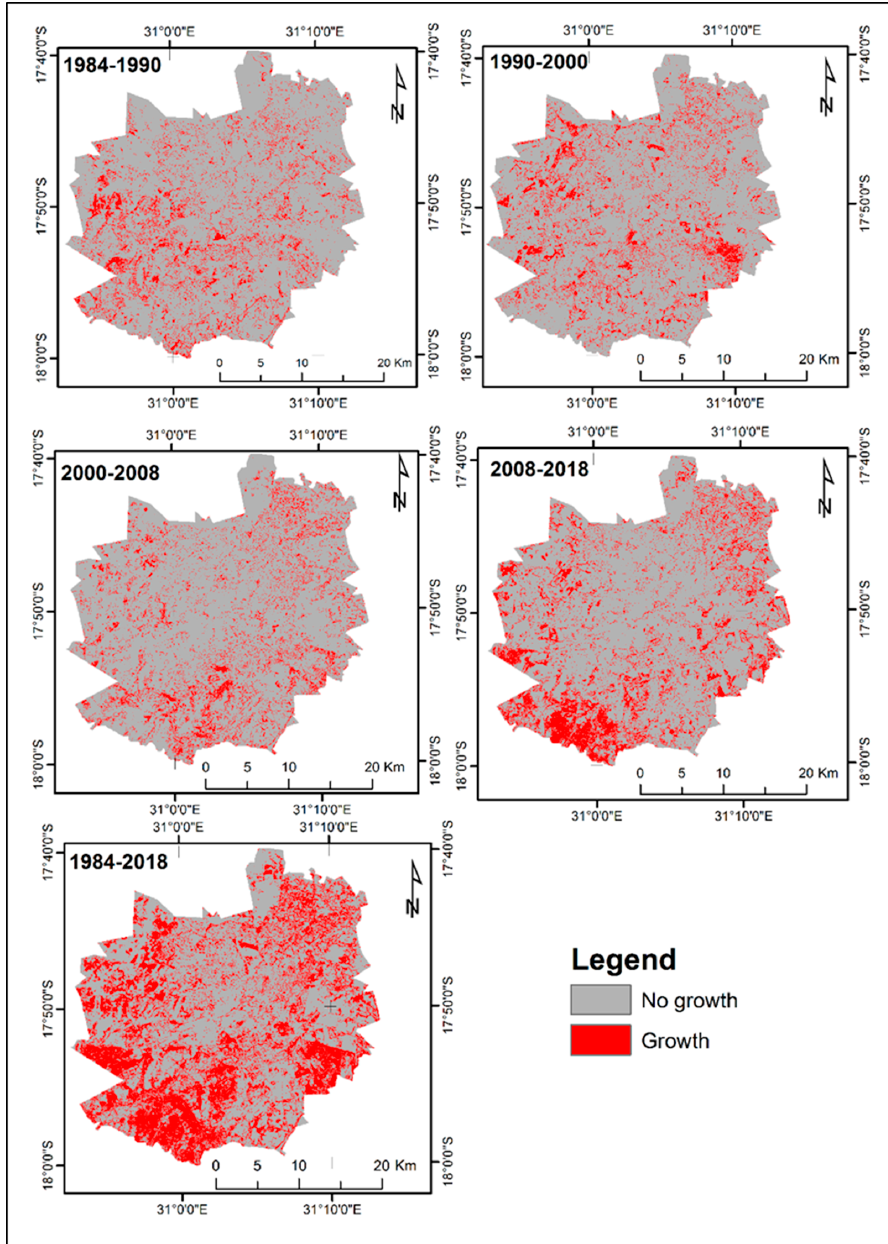
Figure A1. Raster layers for dependant variables for all time slices derived from change detection: 1984–1990; 1990–2000; 2000–2008; 2008–2018 and 1984–2018 with urban built-up area growth (=1) and non-built-up area (=0). Table A1. Confusion matrix and associated classification accuracies produced from Landsat 5 TM (1984). The accuracies include kappa (Kc), overall accuracy (OA), producer’s accuracy (PA) and user’s accuracy (UA).